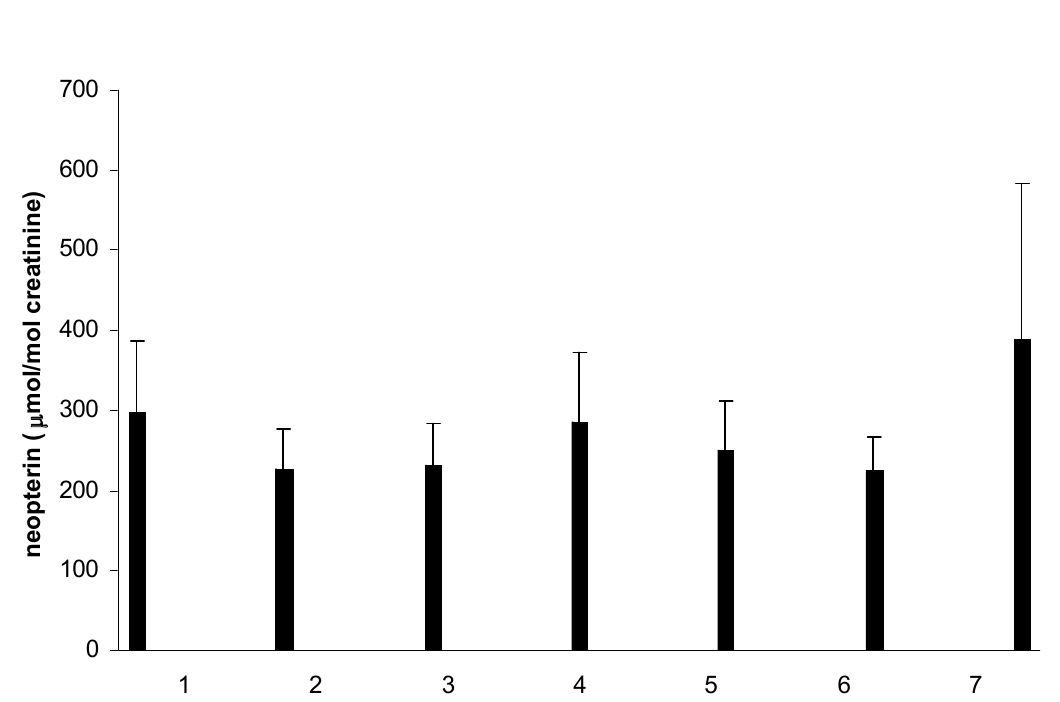
Figure 1. Urinary neopterin during the course of gefitinib therapy, urinary neopterin was determined immediate- ly before the start of gefitinib therapy (visit 1) and at 6 subsequent visits at intervals (median) of 15, 34, 59, 80, 99 and 138 days. Shown are the means, with the error bars indicating standard error of the